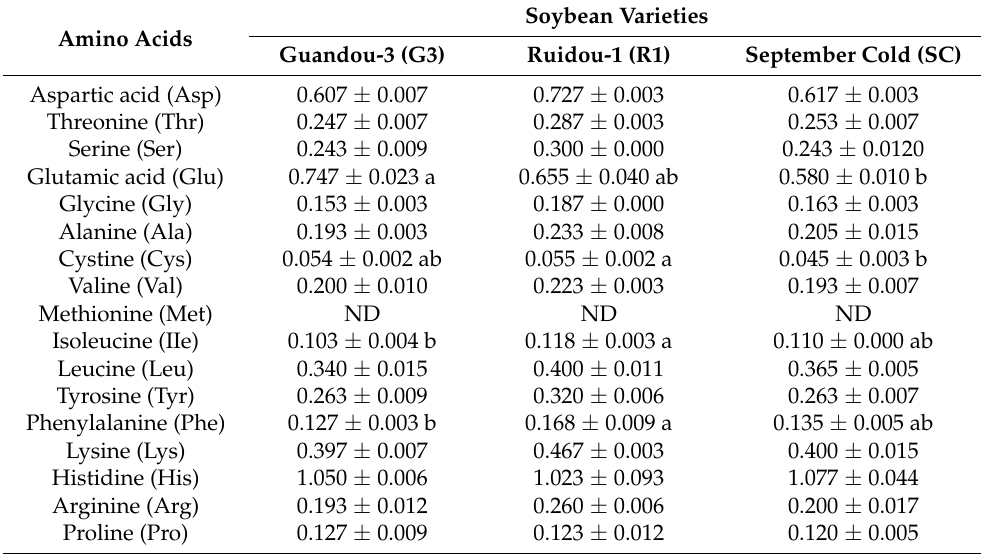
Table 1. The content (g/100g FW) of amino acids in different soybean cultivars. Soybean Varieties Amino Acids Guandou-3